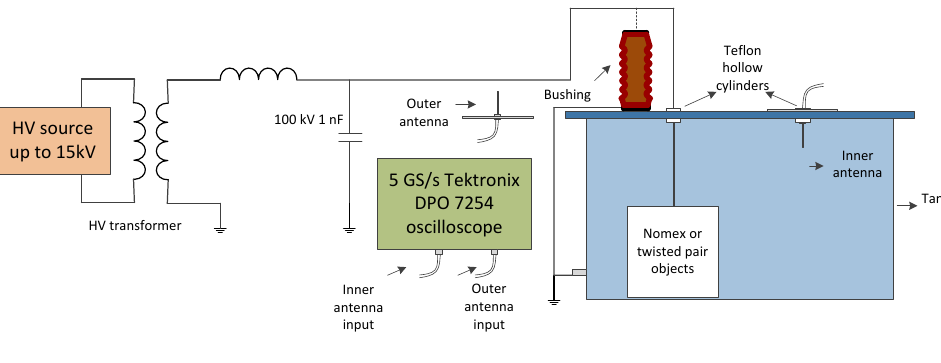
Figure 6. Experimental set-up scheme for the PD acquisitions for the three test objects.